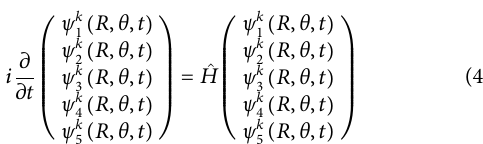
and rotational quantum numbers, respectively. Z (cid:2) (cid:5)